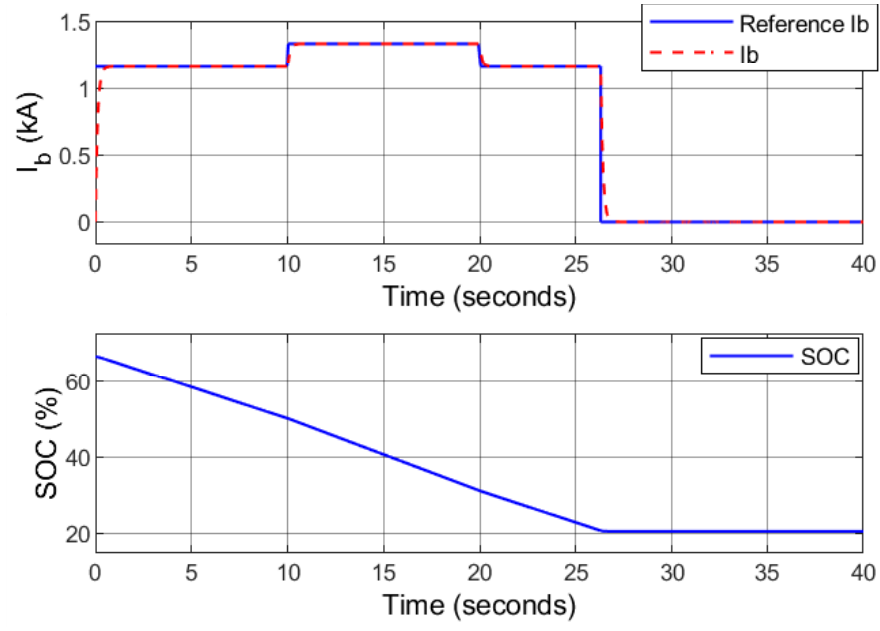
Figure 5. Scenario 1: tracking performance of the battery current and the corresponding